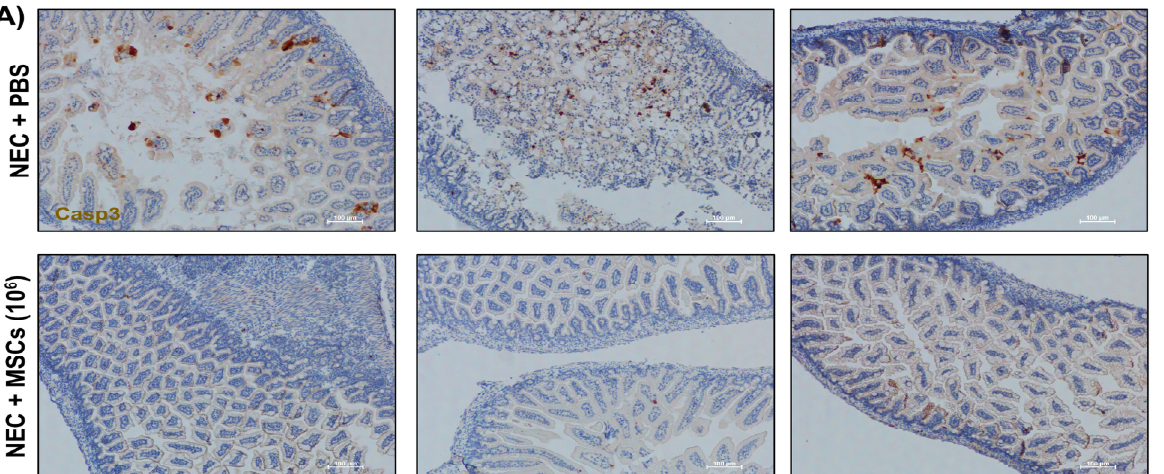
Figure 5. hBM-MSCs reduced apoptosis and stimulated tissue regeneration in a neonatal mouse NEC model. ( A ) Representative Caspase-3 staining on histological intestinal sections from mice belonging to the NEC + PBS and NEC + hBM-MSCs (1 × 10 6 ) experimental groups. Scale bar: 100 μm. ( B , C ) Representative Ki67 staining and its relative quantification on histological intestinal sections from mice belonging to the NEC + PBS and NEC + hBM-MSCs (1 × 10 6 ) experimental groups ( n = 5) Scale bar: 200 μm. ( D ) Relative gene expression of the anti-apoptotic gene Bcl2 and the pro- inflammatory cytokine IL-1B. ( E ) Relative gene expression of the tight junction component ZO-1 in the four indicated experimental groups. Bcl2: B-cell lymphoma 2; hBM-MSCs: human bone marrow- derived mesenchymal stromal cells; IL-1B: Interleukin 1b; NEC: necrotizing enterocolitis; PBS: phosphate-buffered saline; ZO-1: zonula occludens-1. * p < 0.05; ** p < 0.01. In these mice, we also found a reduced expression of the pro-inflammatory cytokine gene IL1b ( p = 0.028) (Figure 5D, right panel) in accordance with the anti-inflammatory function exerted by MSCs [72]. We next evaluated whether hBM-MSCs accelerated the regenerative process upon NEC injury. We stained intestine sections from the different experimental groups with ki67, a marker of active proliferation. The intestines of mice exposed to NEC + PBS showed a higher number of epithelial cells positive for Ki67. On the contrary, in the intestines of